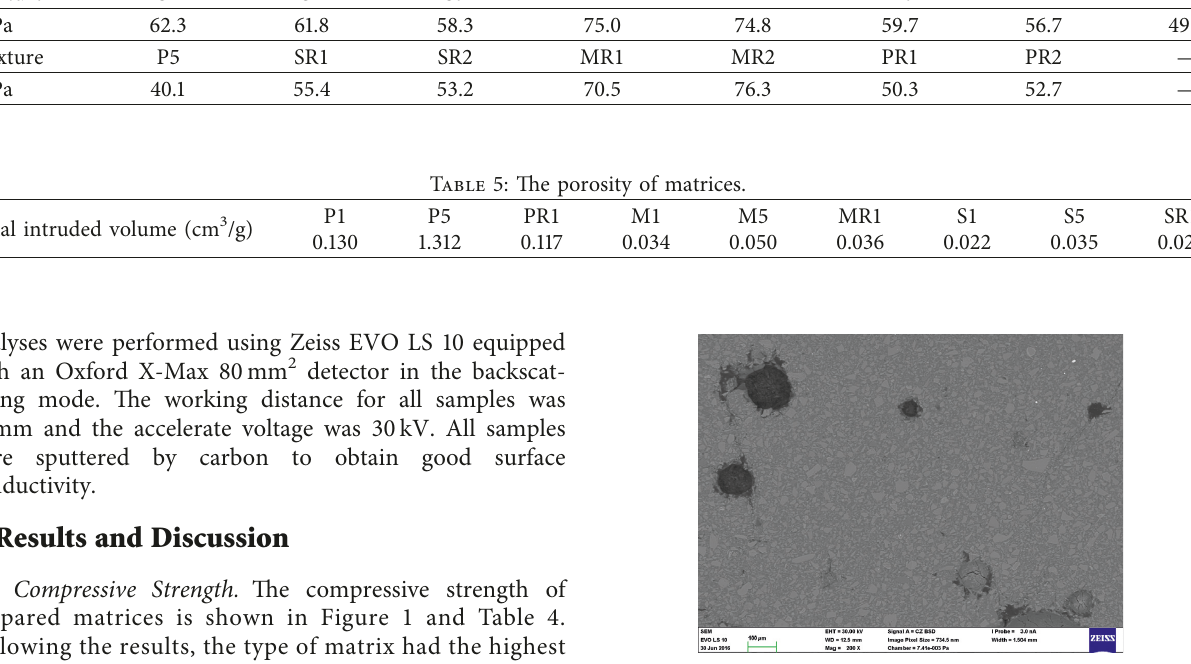
Figure 2: The microstructure of SR2 matrix.